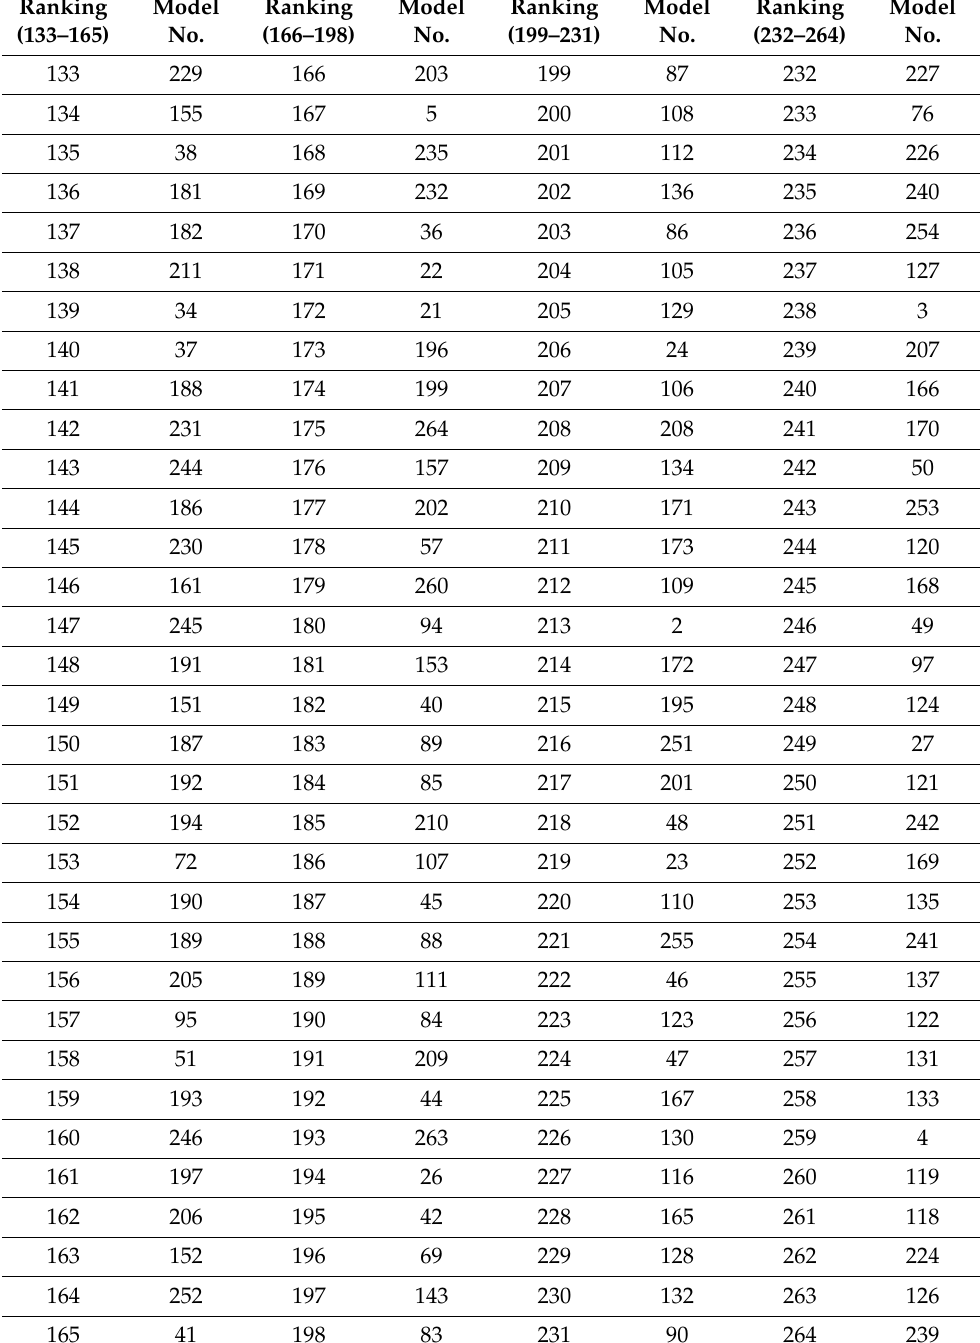
Table 3. Forecasting model ranking for the position from 133 to